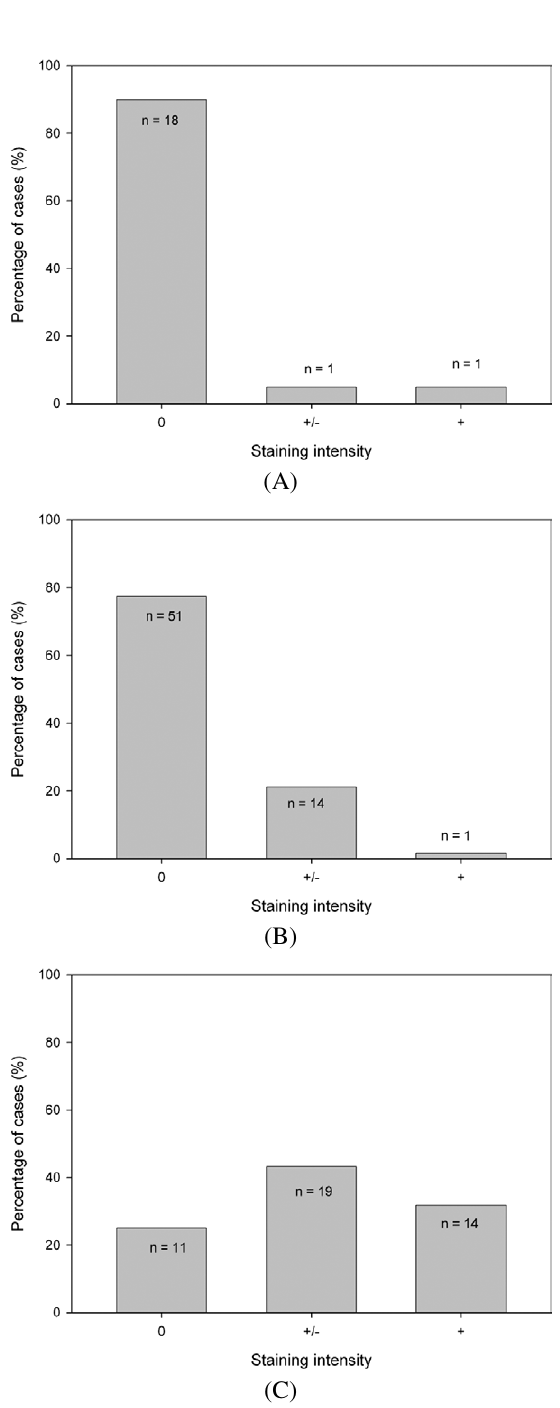
Fig. 5. Cytoplasmic expression of cFLIP in normal colon tissue (A), colorectal adenomas (B) and colorectal carcinomas